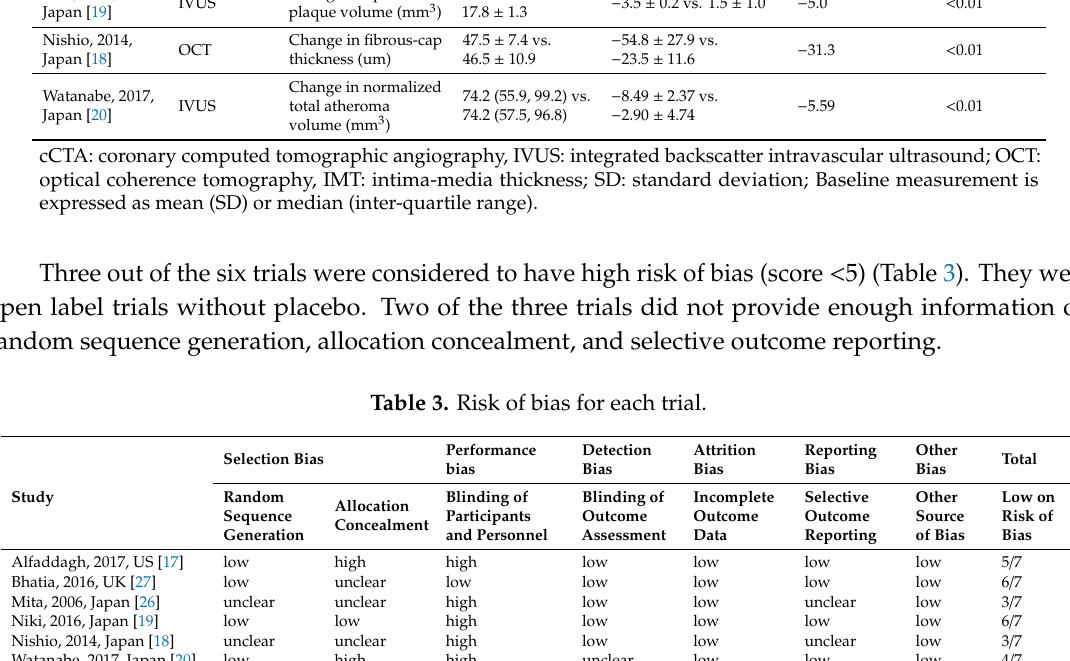
Table 3. Risk of bias for each trial.